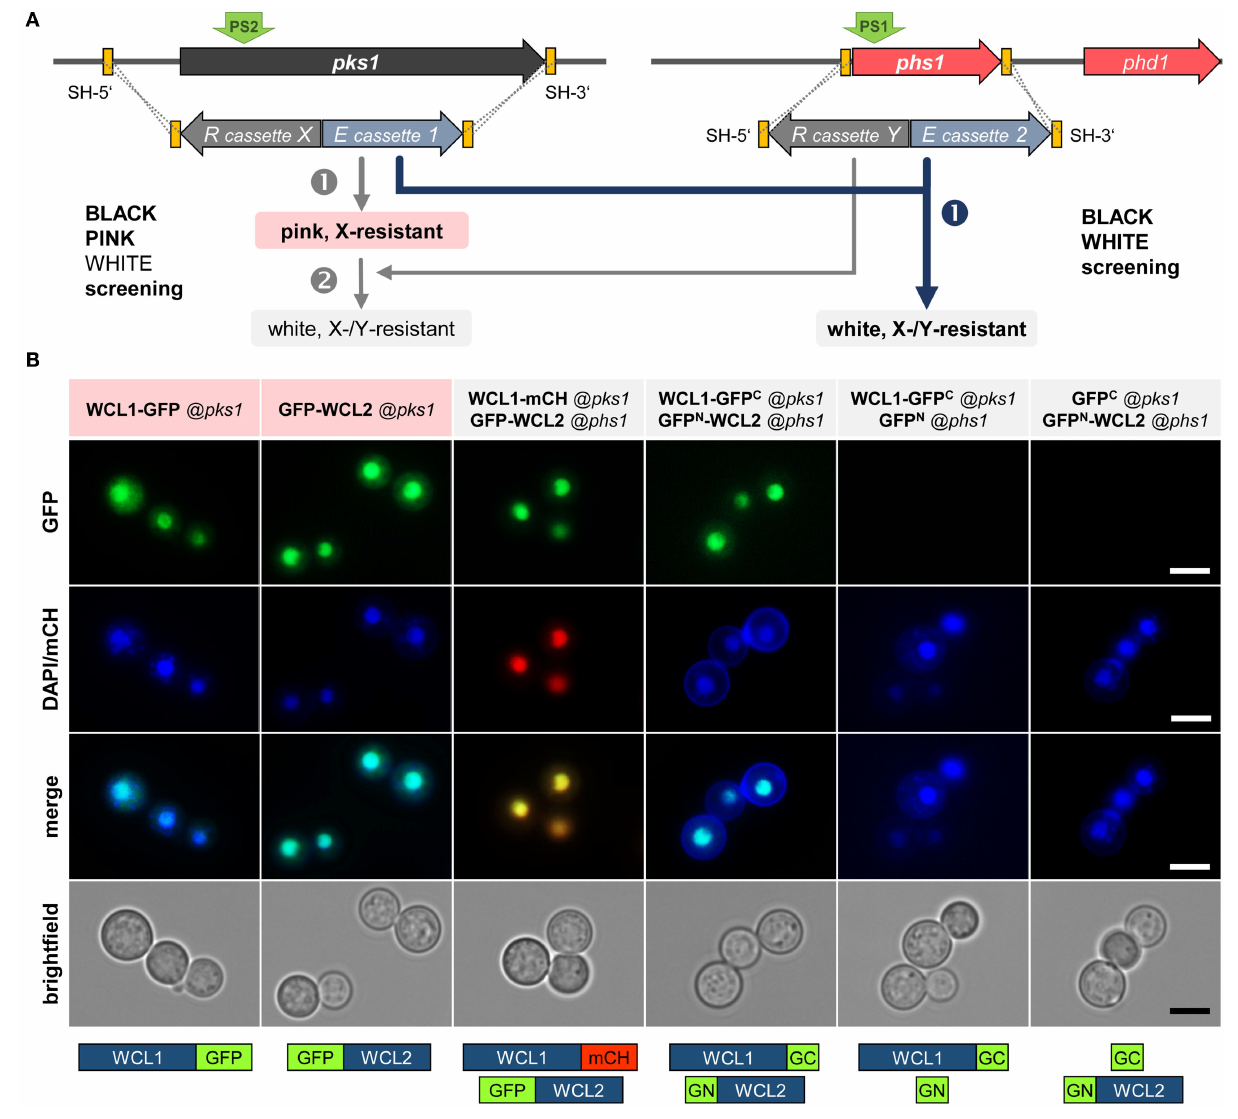
is contained in some basal plasmids (P act1::gfpN ), the